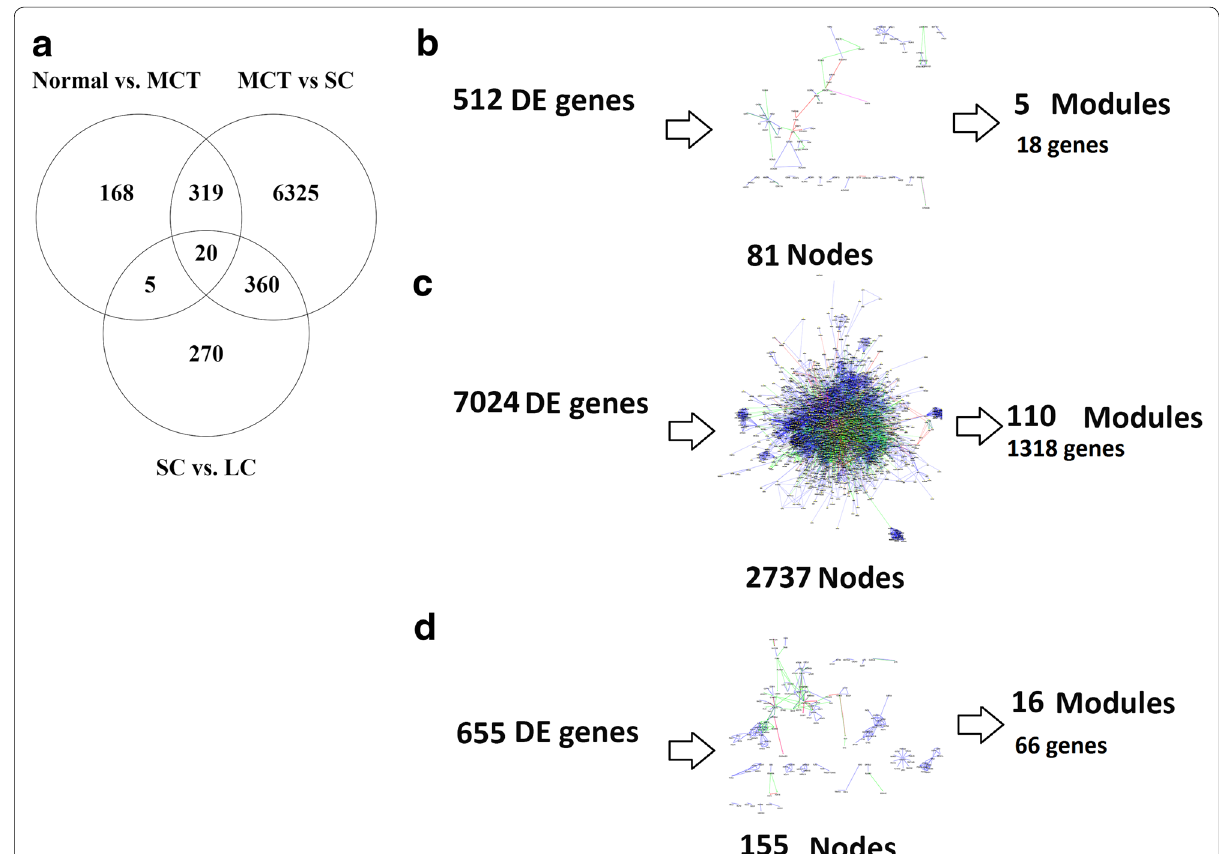
Fig. 2 The overlapping of differentially expressed genes and protein–protein interaction networks. The protein- protein interaction networks were built with differentially expressed genes. b : Normal vs. MCT, c : MCT vs. SC, d : SC vs.